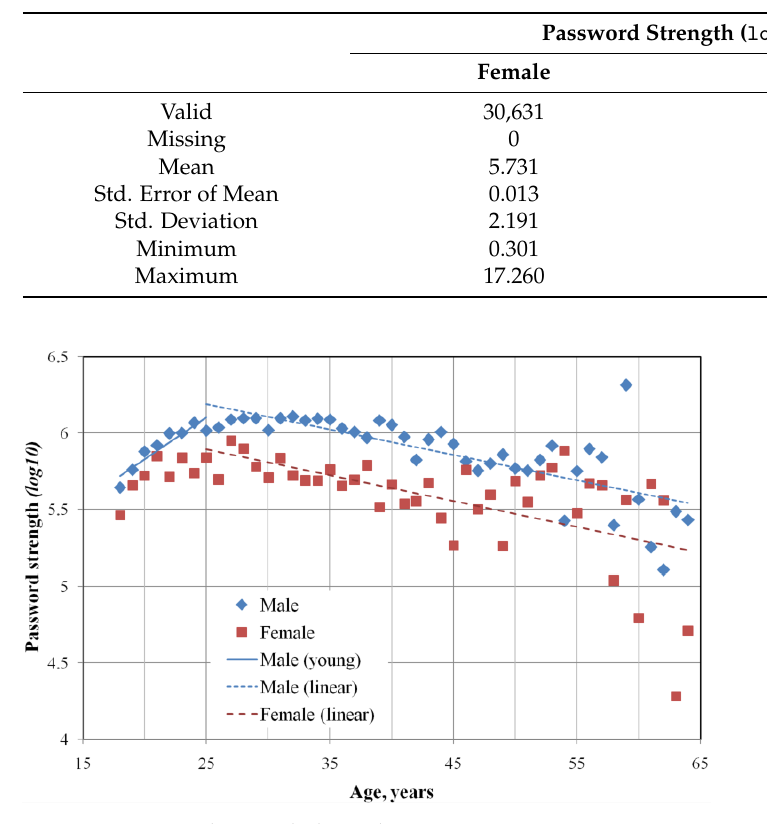
Figure 4. Password strength dependency on person’s